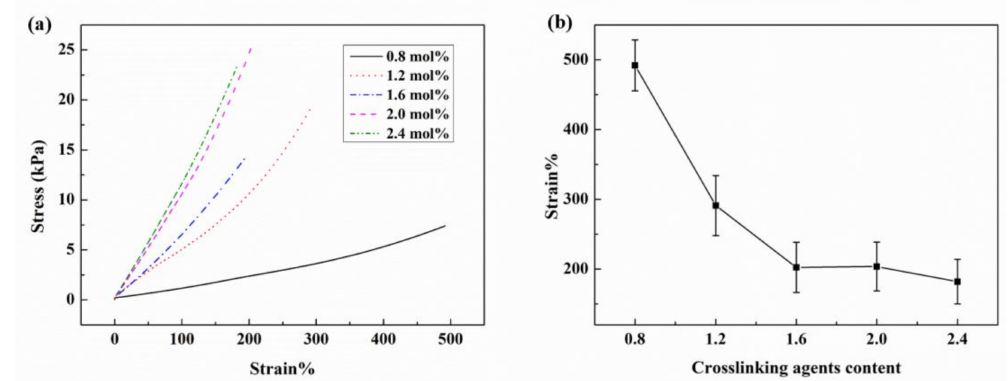
Figure 2. Mechanical properties of ionogel samples with di ff erent contents of crosslinking agents: ( a ) stress-strain curves of ionogel samples with di ff erent contents of crosslinking agents; ( b ) breaking strain of ionogel samples with di ff erent contents of crosslinking agents.